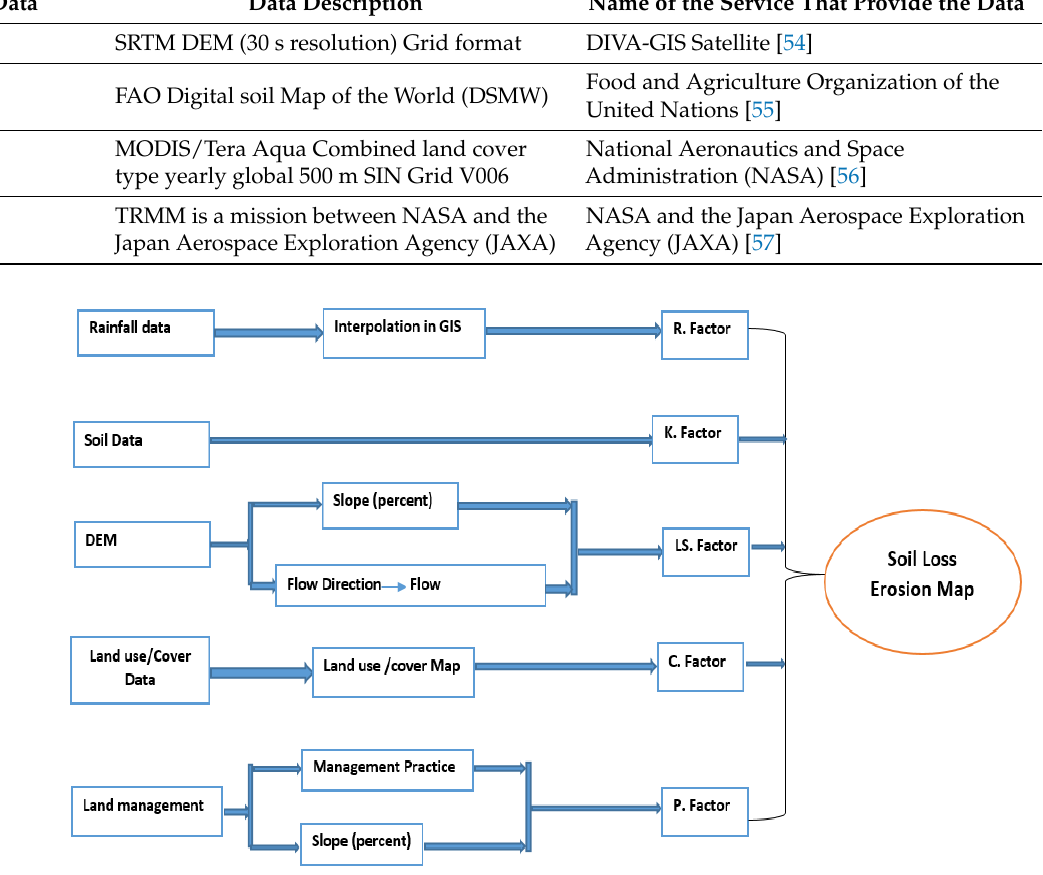
Figure 2. Flow chart for the analysis of soil loss based on the RUSLE model, remote sensing, and GIS technique. Table 1. Description of the data sources.